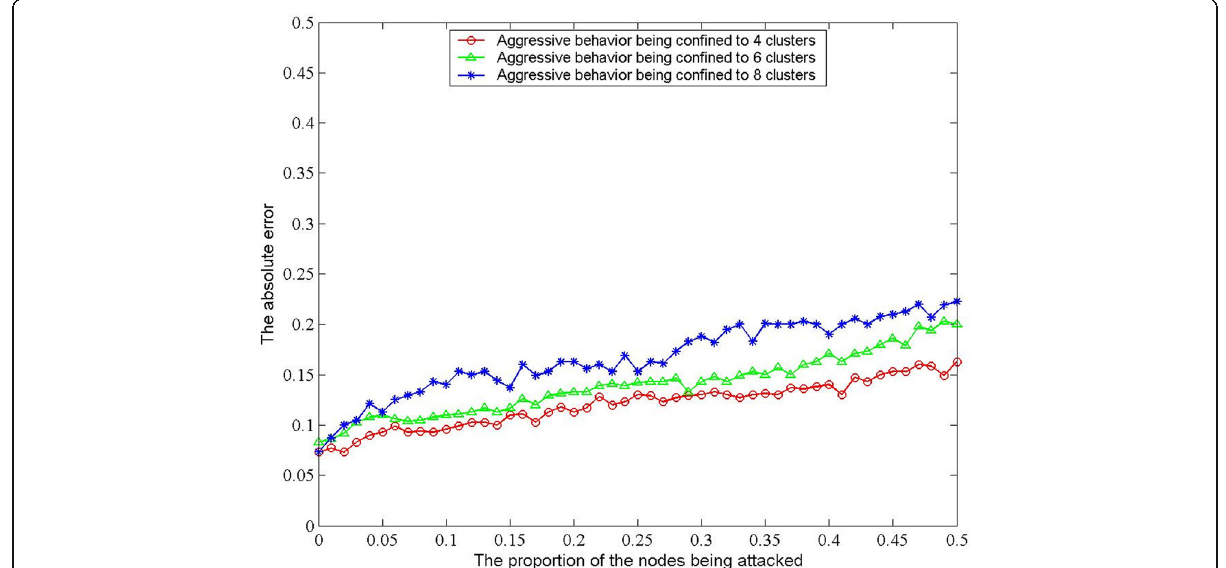
Fig. 1 Absolute error as attacks being occurred in different